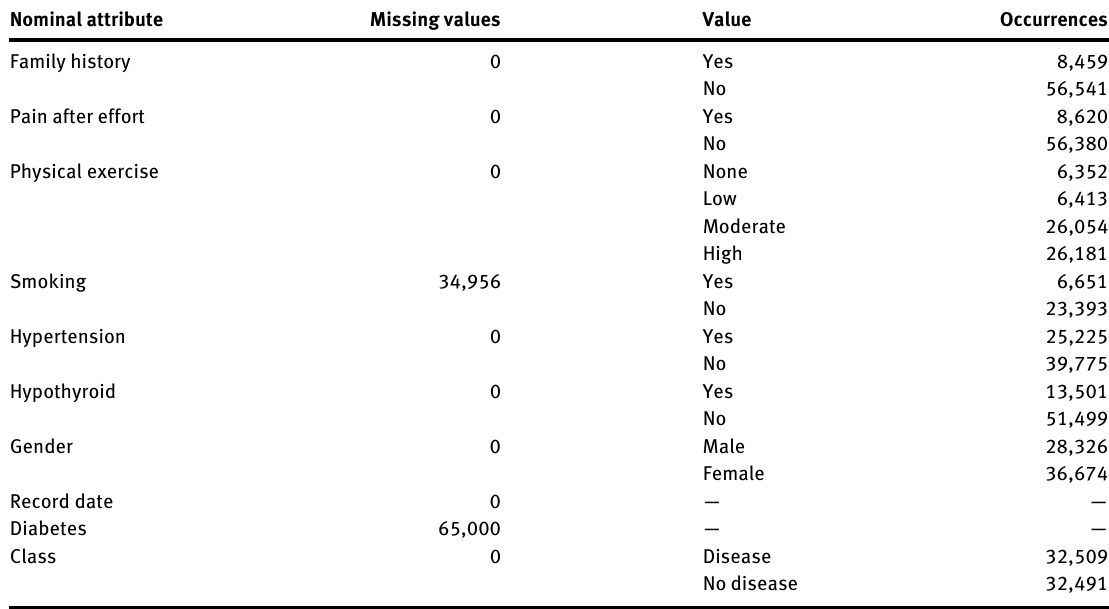
Table 2: General statistics of nominal attributes used for the data mining process (before the process of data cleansing). Nominal attribute Missing values Value Occurrences Family